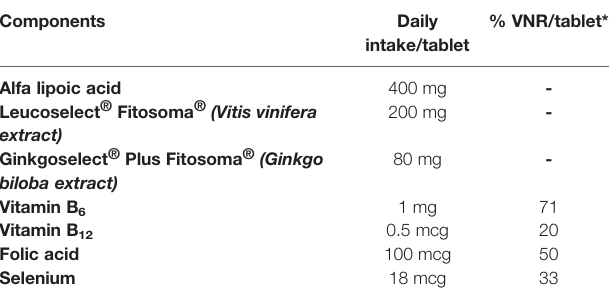
TABLE 2 | Nutraceutical